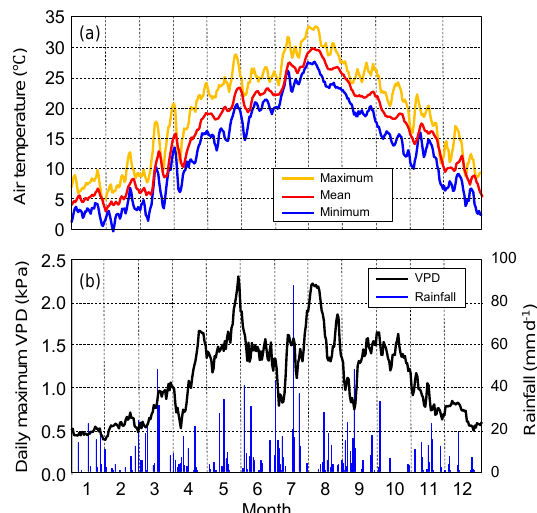
Figure 2. Seasonal variations in (a) daily mean, maximum, and minimum air temperatures and (b) daily maximum vapor pressure deficit (VPD) and daily total rainfall. Temperatures and VPD were measured at 111m above the ground at the SAC site and rainfall was measured at the OPU site, during 2015. Temperatures and VPD are shown as a 7-day running